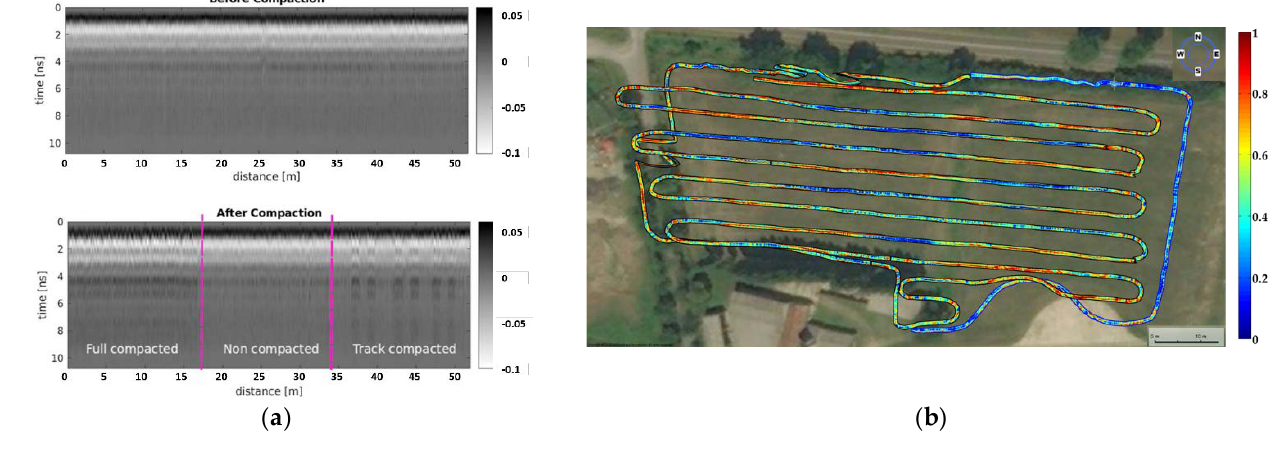
Figure 9. GPR prospecting for soil structural properties. ( a ) Identification of compacted zones in a field experiment [251]. ( b ) Delineation of highly reflective morphological anomalies through the analysis of the GPR amplitude characteristics (red to blue colour scale) [269].